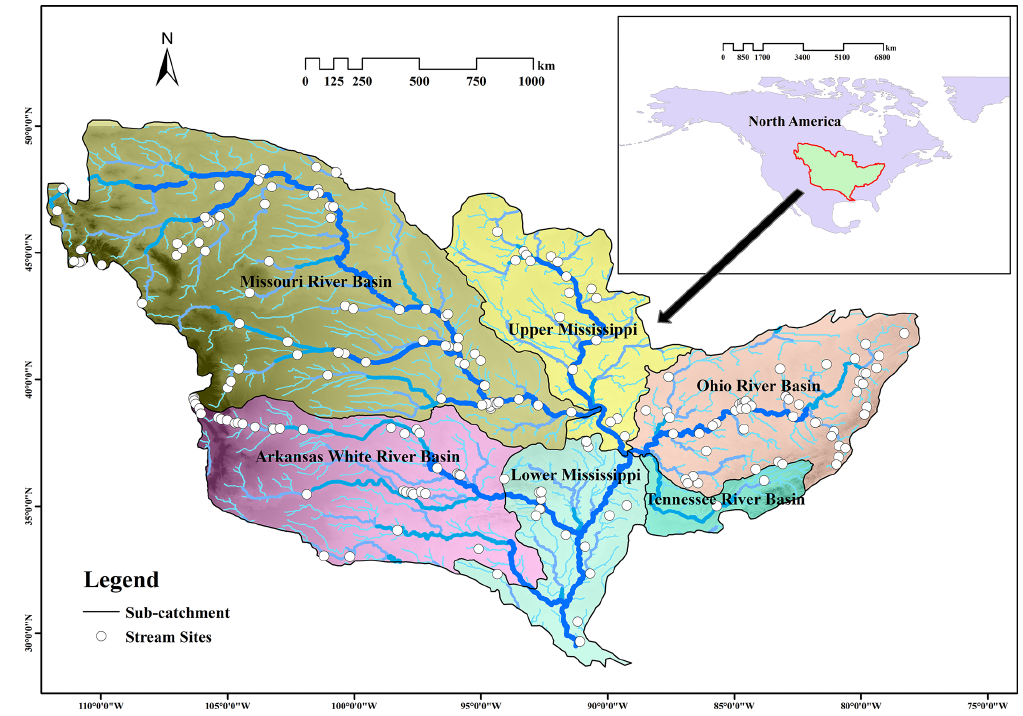
Figure 1. Map showing the Mississippi River basin and the locations of the 201 stream gauging sites included in the present